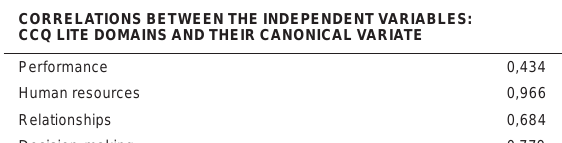
Pearson correlations between the dimensions of the MQ and the domains of the